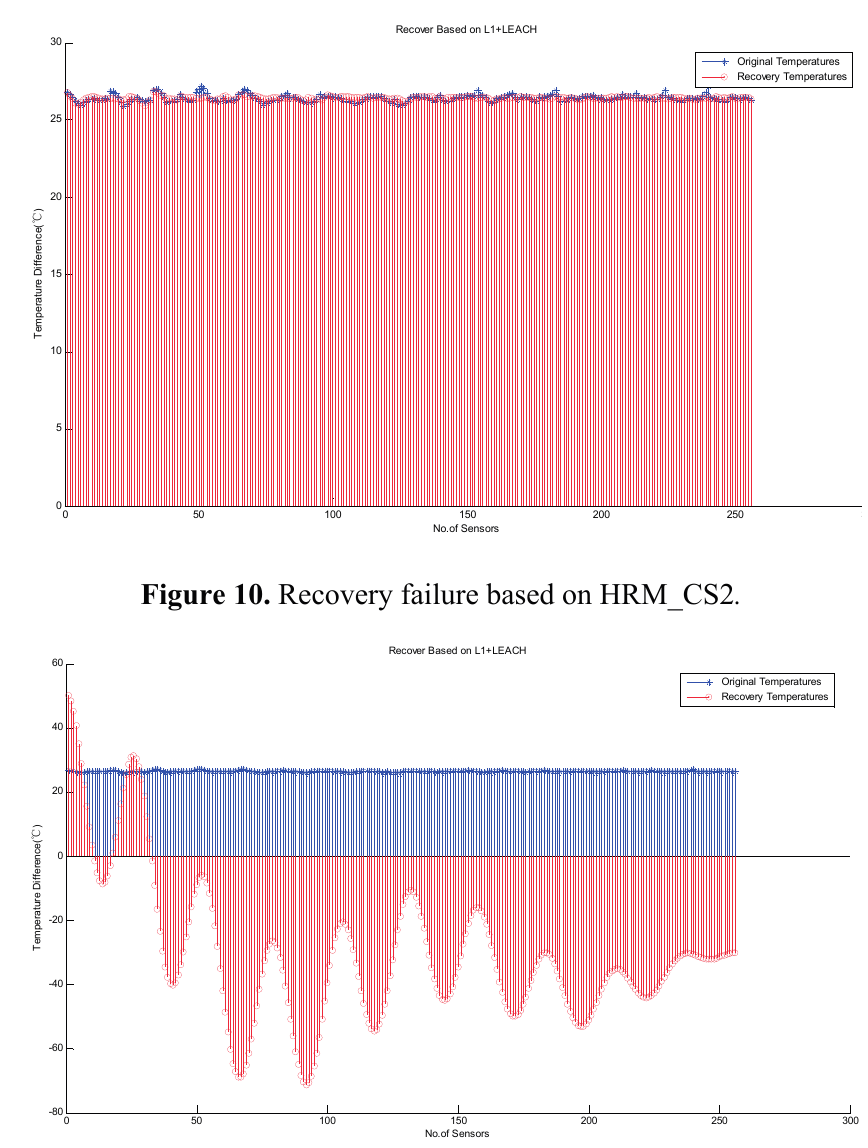
Figure 9. Recovery based on HRM_CS2 .